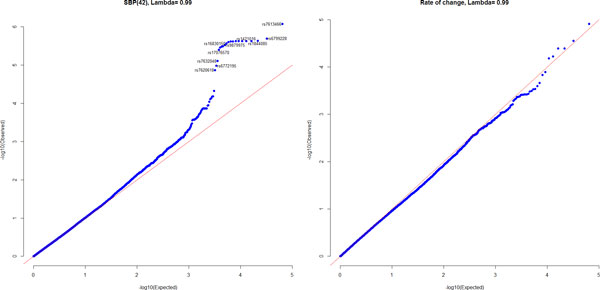
Q-Q plots for the observed against expected p values in association analysis of chromosome 3 data, for SBP(42) (left panel) and for rate of change (right panel).